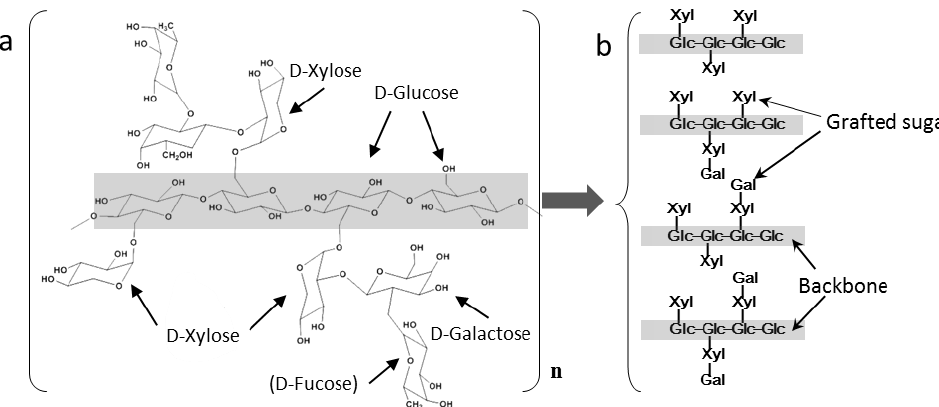
Figure 1. Chemical structure of XG, repeated n times, indicating the central backbone and the grafted saccharides ( a ); four possible sequences of repeating units ( b ) depending on the origin of XG (Glc: glucose; Xyl: xylose; Gal: galactose). D-fucose may not be present. (Adapted from Shirakawa et al. [15] with permission from